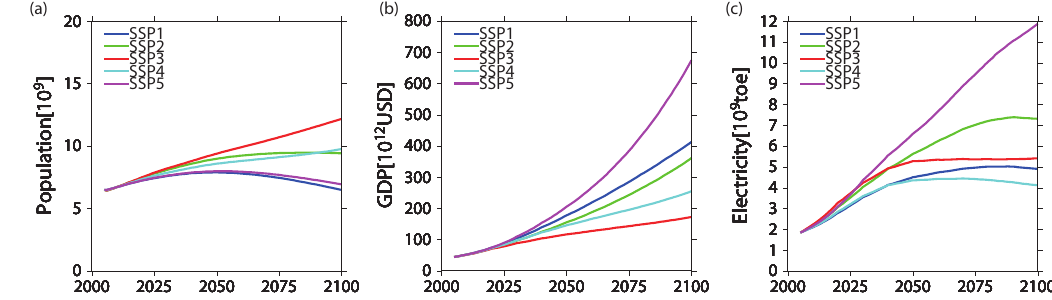
Fig. 2. Socio-economic factors of AIM-SSP. (a) Population, (b) GDP, and (c) electricity production of each SSP.